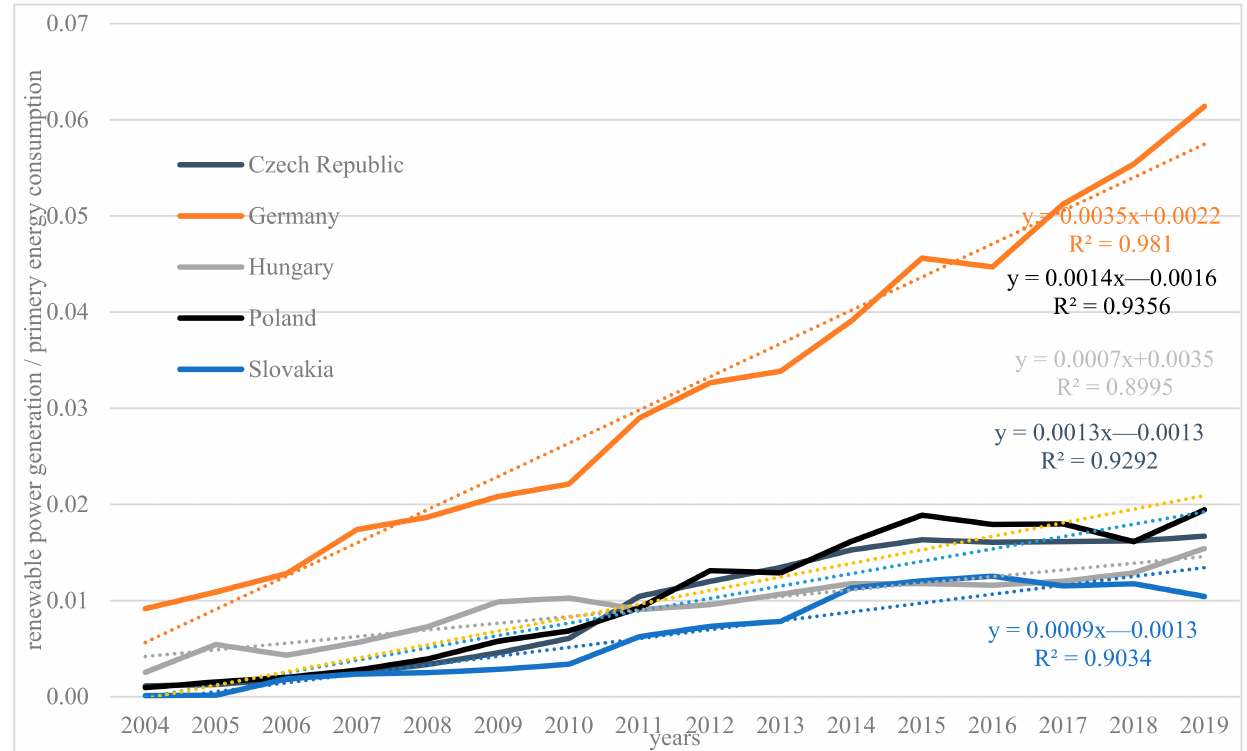
Figure 2. The corelation of Poland, the Czech Republic, Hungary and Slovakia in relations to Germany variant III. The delay of Poland, the Czech Republic, Hungary and Slovakia in relations to Germany, as shown by the analysis of the data obtained using variant III of the method, dynamically changes over time (see Table